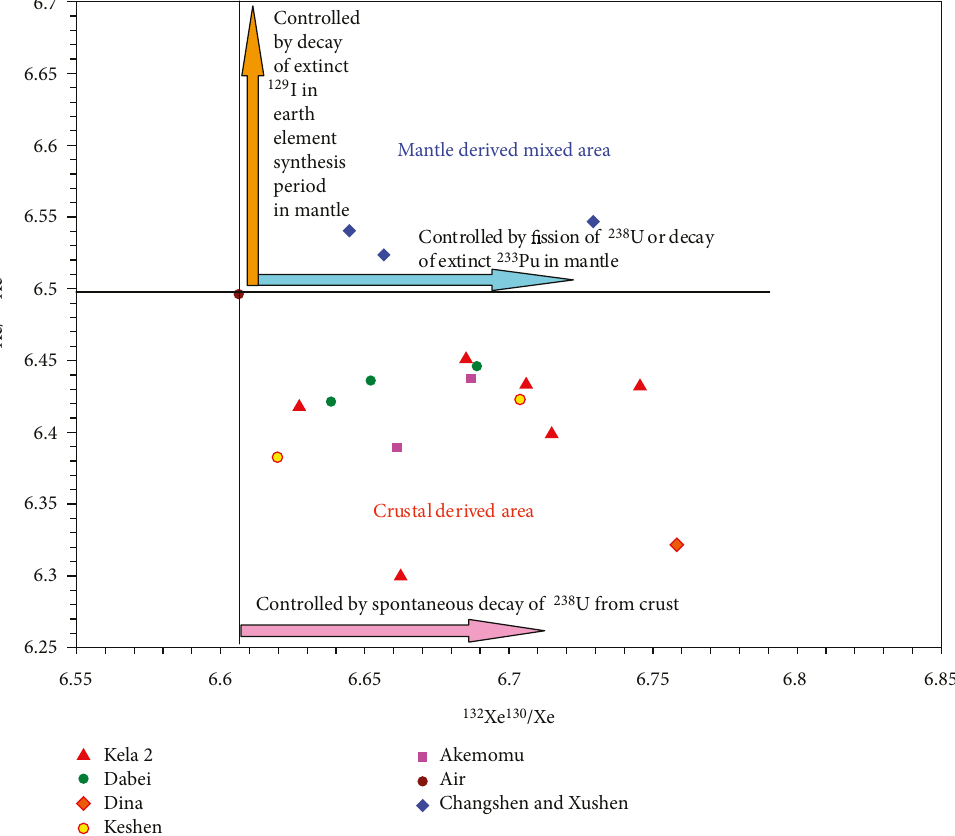
Figure 9: Genetic identi fi cation of 129 Xe/ 130 Xe- 132 Xe/ 130 Xe for some gas fi elds from the Kuche and Southwestern Depressions, Tarim Basin (chart modi fi ed from